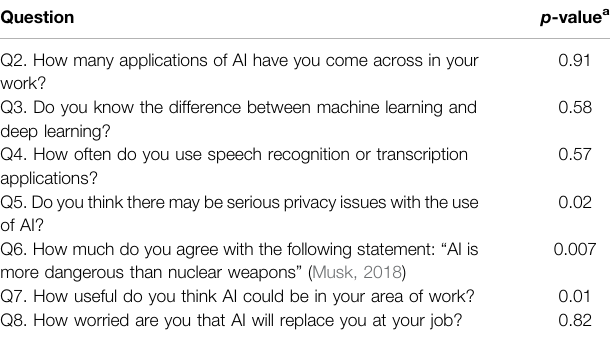
TABLE 3 | Subgroup analysis according to participants ’